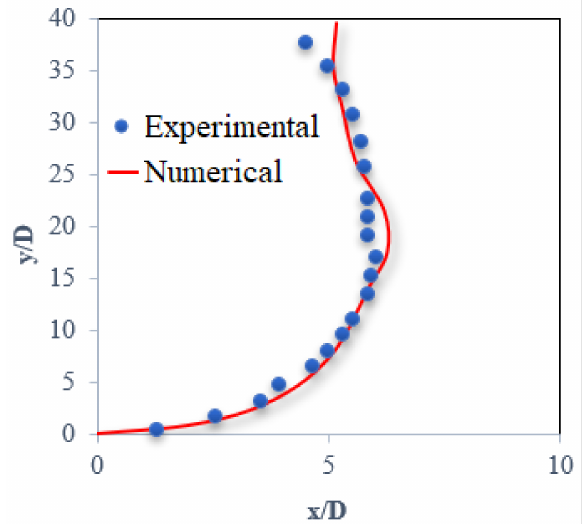
Figure 2. Comparison of the experimental and simulated results. The dots = the experimental data [1]; the line = the numerical